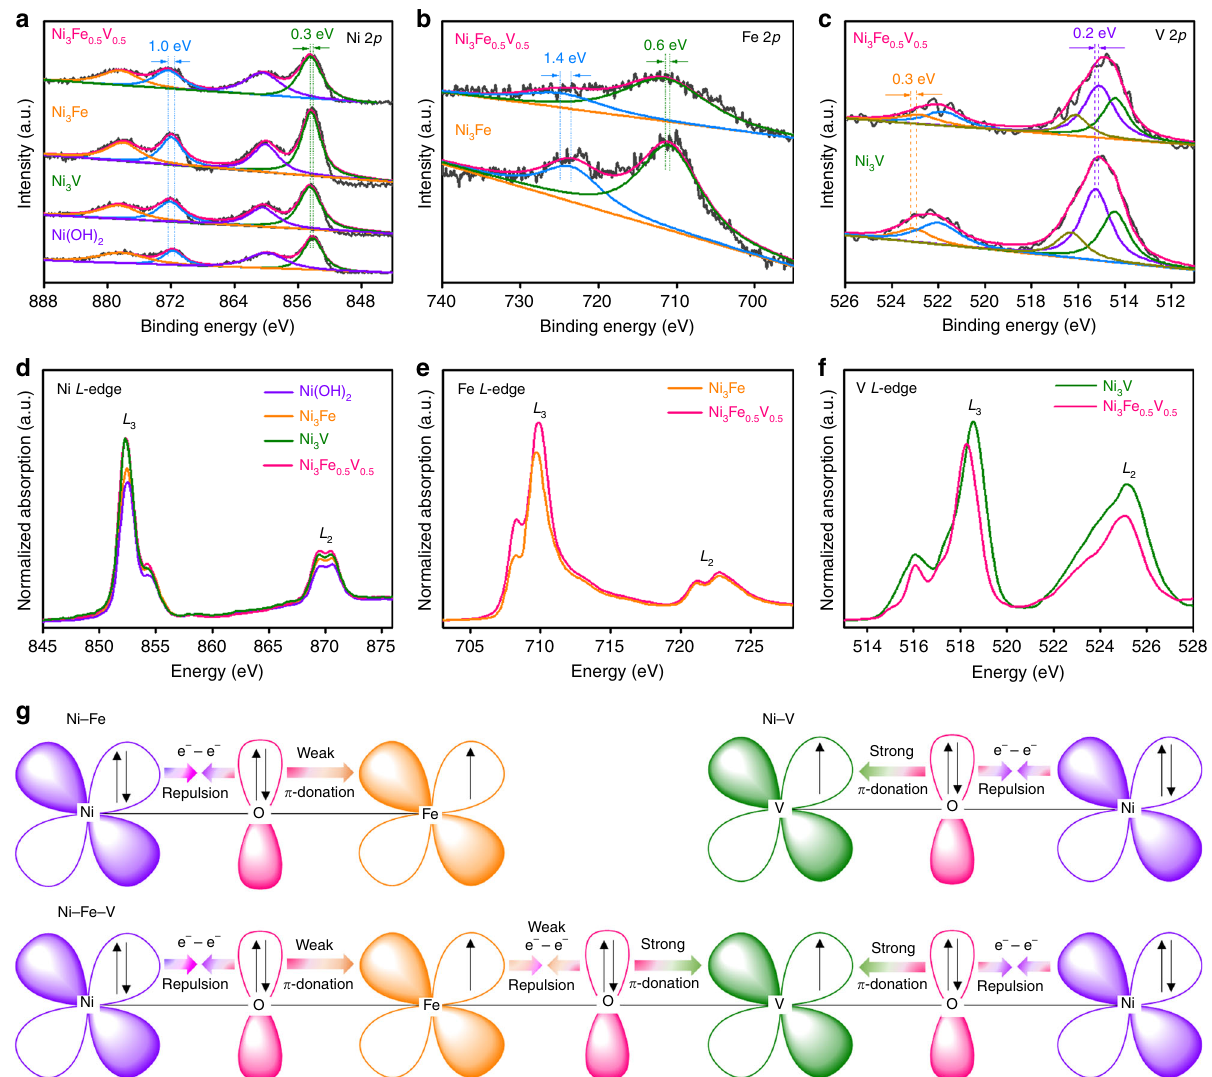
Fig. 4 High-resolution XPS and XANES spectra of the as-prepared Ni-based (oxy)hydroxide catalysts. XP spectra of a Ni 2 p for Ni 3 Fe 0.5 V 0.5 , Ni 3 Fe, Ni 3 V, and pure Ni (oxy)hydroxides, b Fe 2 p for Ni 3 Fe and Ni 3 Fe 0.5 V 0.5 , and c V 2 p for Ni 3 V and Ni 3 Fe 0.5 V 0.5 (the dashed lines shown in a – c indicate the shifts of BEs of 3 d metal ions caused by the hybridization of Fe or/and V dopants). d – f Ni, Fe, and V L -edge XANES spectra. g Schematic representations of the electronic coupling among Ni, Fe, and V in Ni 3 Fe, Ni 3 V, and Ni 3 Fe 0.5 V 0.5 bridging O 2 − via π -donation, while the dominant interaction and Ni 2 + with half-full e g orbitals would have very weak bonding between the fully occupied π -symmetry ( t 2g ) d -orbitals of Ni 2 + with adsorbed oxygen species, whereas the V 4 + and V 5 + with e g 0 and the bridging O 2 − is electron – electron repulsion, leading to orbitals would form too strong bonding with adsorbed oxygen partial electron transfer from Ni 2 + to Fe 3 + (refs. 12,40 ). The species. To get high OER activity, the bonding strength between transition metal and adsorbed oxygen species should be partial electron transfer from π -symmetry lone pairs of the optimized to ful fi ll the Sabatier principle 47 . With increase of the bridging O 2 − to V 4 + and V 5 + in Ni 3 V should be stronger than that from the bridging O 2 − to Fe 3 + in Ni 3 Fe, as V 4 + and V 5 + electron density on V by partial electron transfer from Fe and Ni have rather low t 2g occupancy while Fe 3 + has a half t 2g to V through the bridging O 2 − ions, the high valence states of V occupancy. As for the Fe/V co-doped Ni(OH) 2 with some of could be stabilized under OER conditions, and more importantly, the V and Fe atoms aggregated in the host lattices, when Fe 3 + the strong bond strength between V and adsorbed oxygen species accepts partial electrons from Ni 2 + through the bridging O 2 − via could be tuned to a moderate bond strength, which would bene fi t π -donation as exampled by the NiFe (oxy)hydroxide reference, for releasing O 2 from the V site in OER. the electron-riched t 2g d -orbitals of Fe 3 + could relay electrons to the strongly electron-de fi cient t 2g d -orbitals of V 4 + and V 5 + Evaluating the electrochemical OER performance of through the bridging O 2 − ions between them, which leads to better delocalization of the π -symmetry electrons among Ni, Fe, and V in the host matrix. This argument is in good agreement with the XPS and soft XANES results. In Ni 3 Fe 1 − x V x , the Fe 3 +